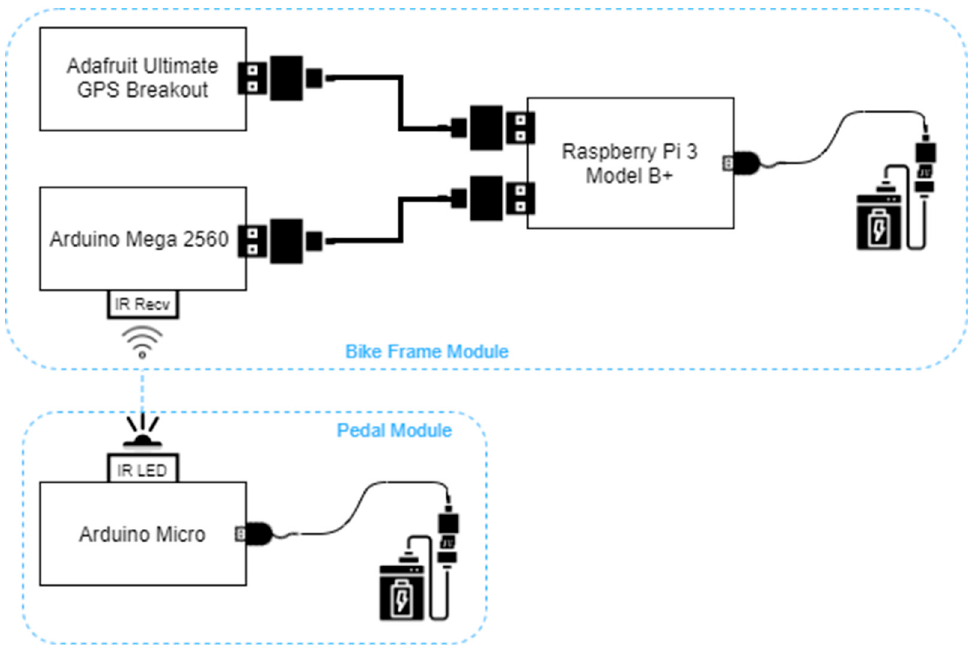
Figure 2. The hardware scheme.